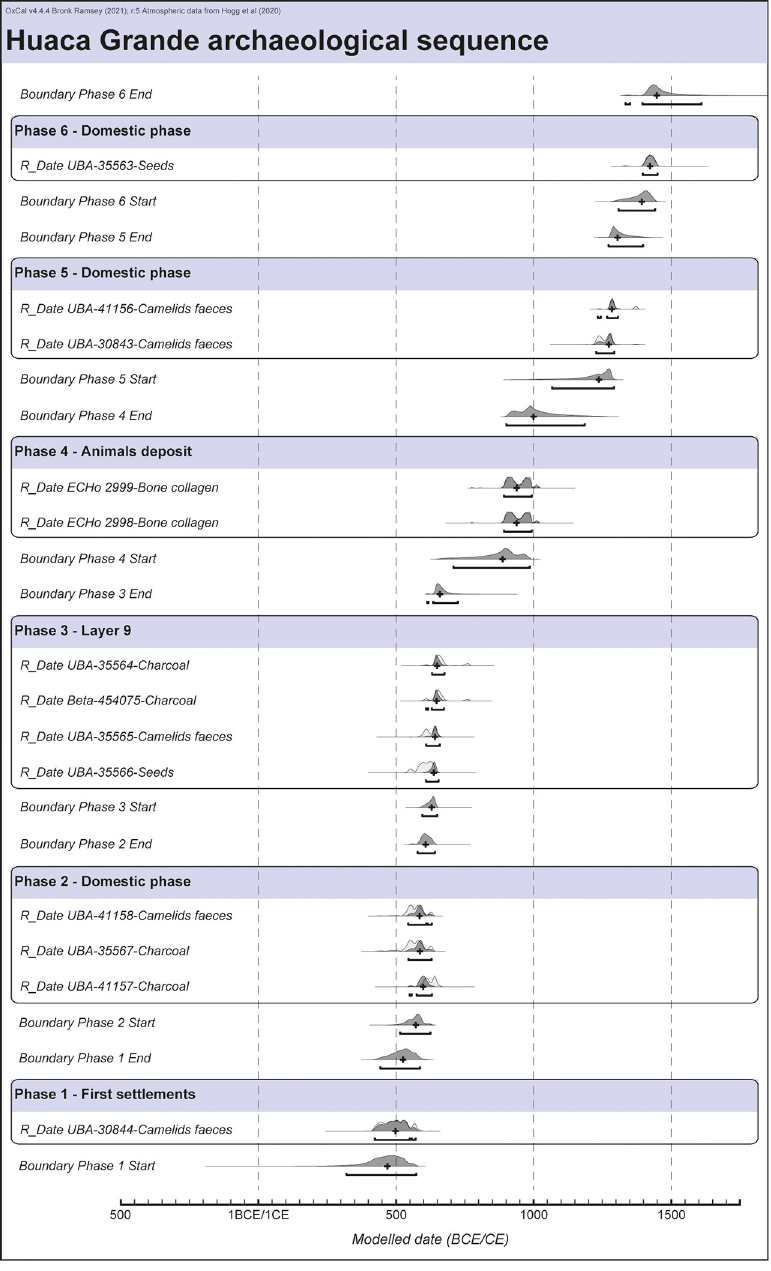
Fig 9. Bayesian chronological modelling of radiocarbon ages from the occupation phases of the Huaca Grande archaeological site. The simple calibrated radiocarbon age distributions are represented in light grey; the posterior probability distributions determined via the modelling are represented in dark grey. This figure was generated using OxCal 4.0 [35] and then modified.